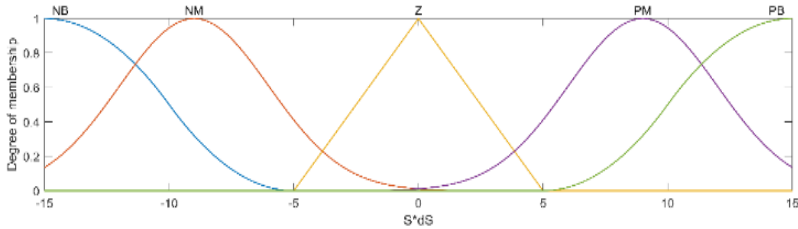
Figure 10. Fuzzy control input.